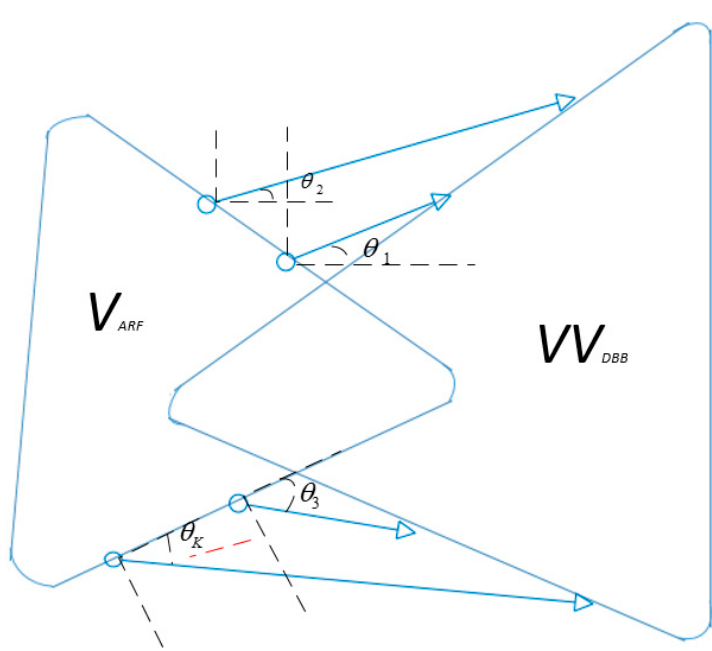
Figure 2. Euclidean projection.